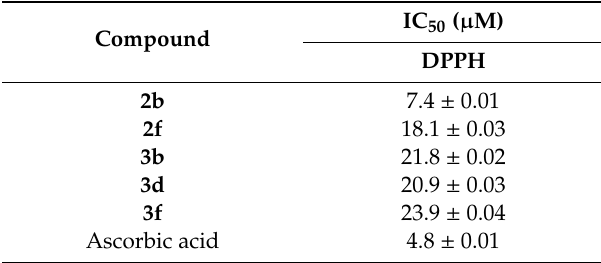
Table 6. Evaluation of 2b , 2f , 3b , 3d and 3f for antioxidant